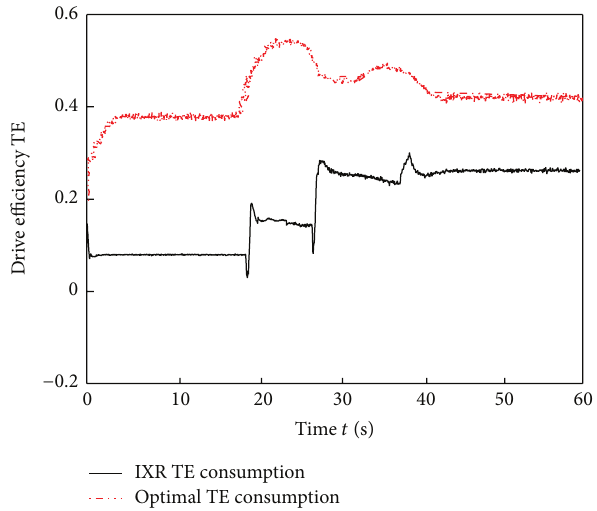
Figure 17: Drive efficiency comparison of different control strategy.